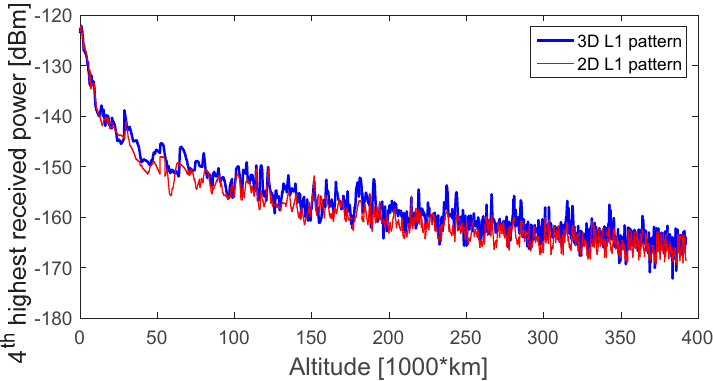
Figure 9. Fourth-highest received power level of GPS L1 signals, during the considered MTO, for a 0 dBi receiver gain pattern.